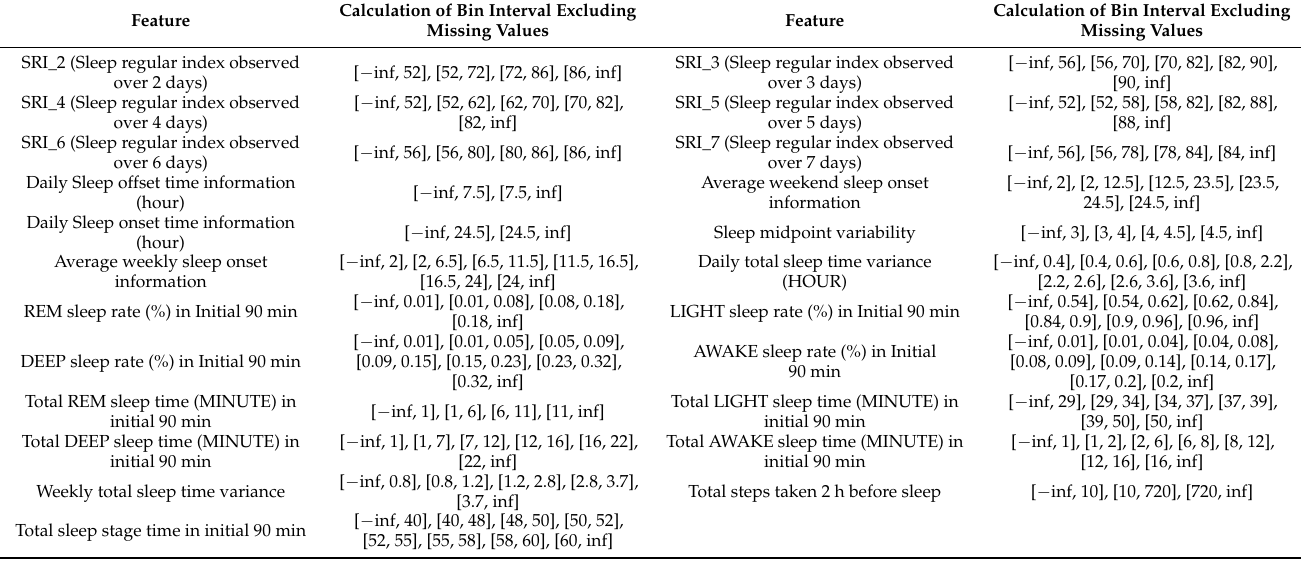
Table 3. Interval range information for each feature based on WoE